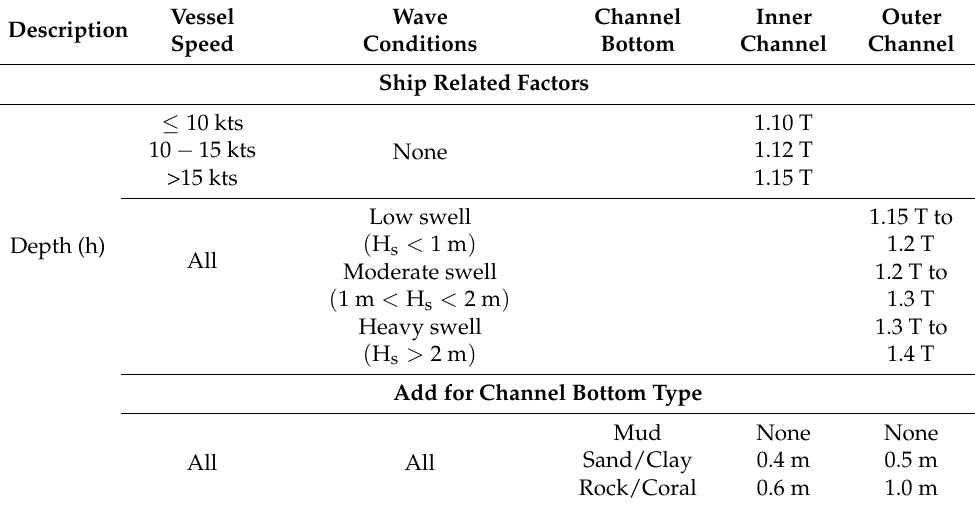
Table 2. The World Association for Waterborne Transport Infrastructure (PIANC)’s depth components.